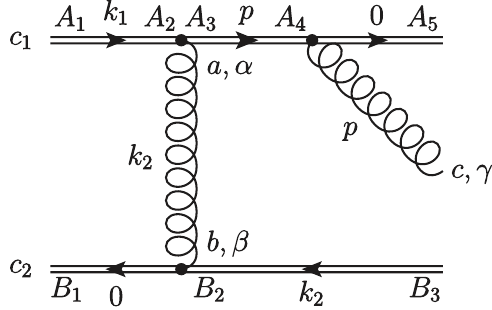
Figure 3 . One of the non-QCD Feynman diagrams which restore gauge invariance in the scattering amplitude of g (cid:3) ( k 1 )+ g (cid:3) ( k 2 ) g c ( p ) in the Wilson lines formalism. The outgoing gluon is c 1 c 2 !